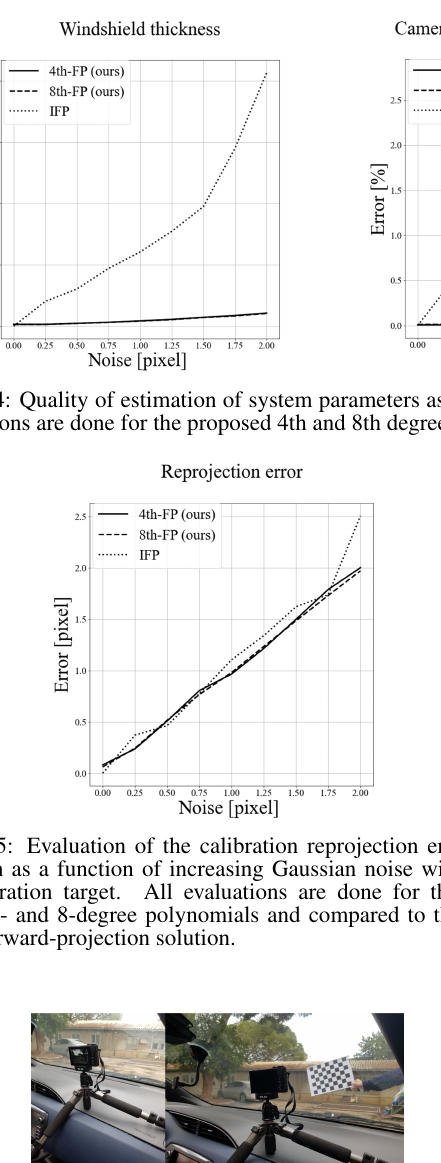
Figure 3: Pose estimation error, using the refraction-invariant model by Elnashef and Filin (2019) with 2-D targets, as a function of increasing Gaussian noise. Normalized positional error (left); Angular difference between the estimated and true rotation matrix (center); Reprojection error (right).